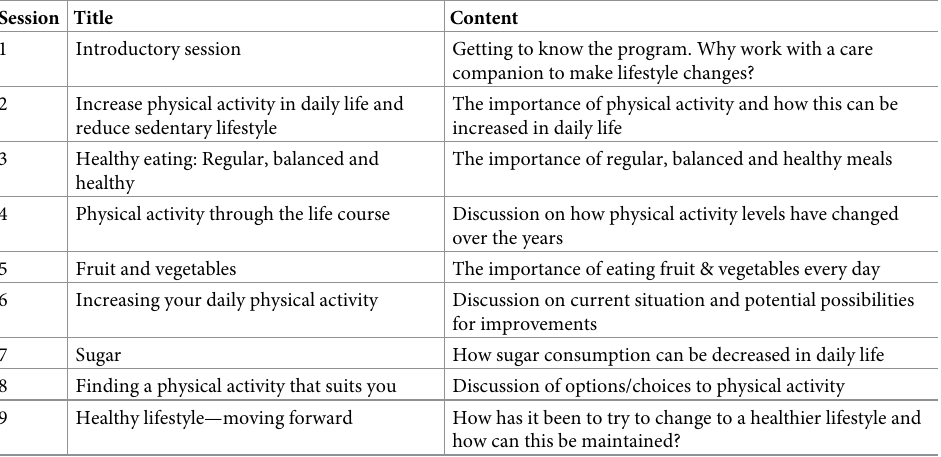
Table 2. Overview of session structure in the telephone-facilitated health coaching